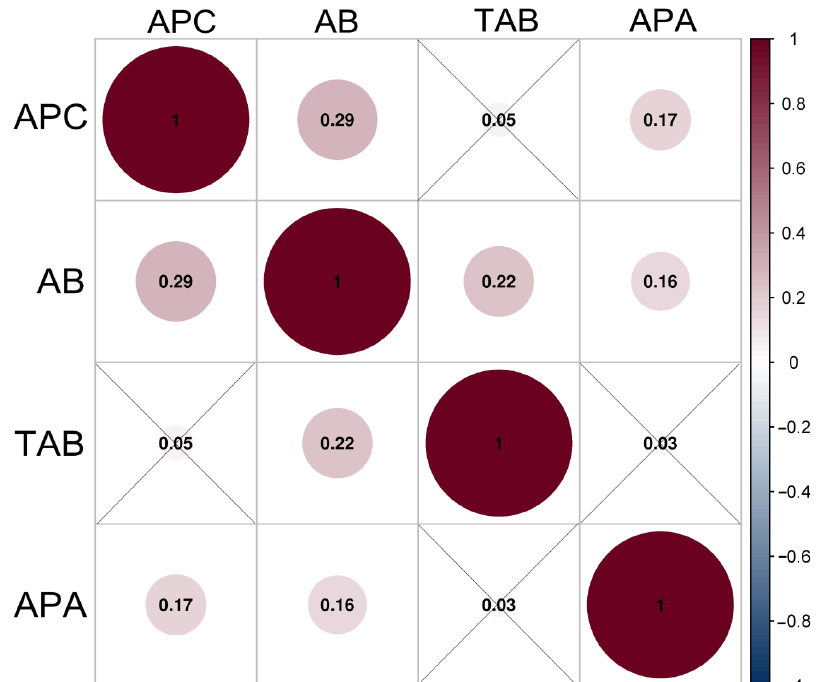
Figure 1. Correlation between the aerobic plate count, aerobic Bacillus count, thermophilic aerobic Bacillus count, and alkaline phosphatase activity of raw milk samples. The p values are shown in circles. The p value > 0.05 is shown in the crossover line, and the other p values are <0.05. APC: aerobic plate count; AB: aerobic Bacillus count; TAB: thermophilic aerobic Bacillus count; APA: alkaline phosphatase activity.